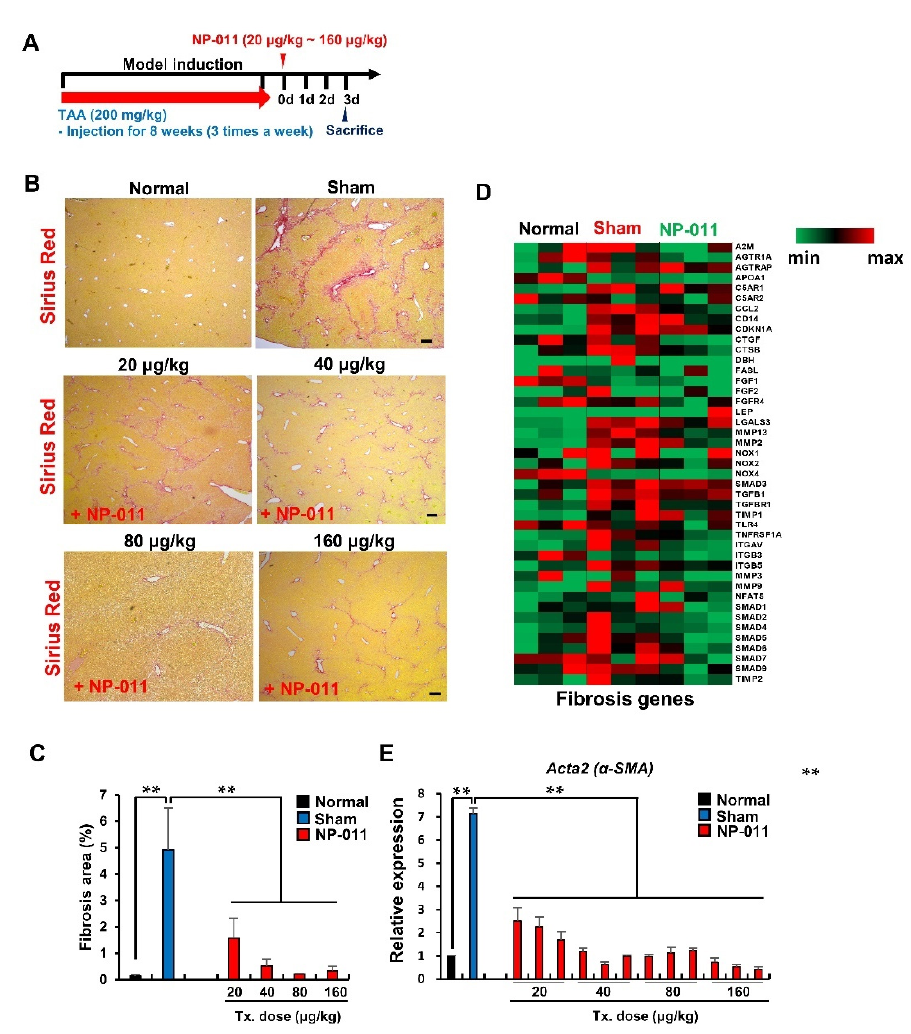
Figure 2. Resolution of fibrosis by administration of various doses of NP-011. ( A ) Overall schematic schedule for testing the efficacy of the NP-011 in a liver fibrosis model. The red arrow indicates the period for TAA administrations for inducing liver fibrosis. ( B ) Representative images for comparing the fibrotic areas (Sirius red stained areas) in the liver of normal mice, a TAA-induced liver fibrosis model, and an NP-011-administered liver fibrosis model at various doses (20–160 μ g/kg). Scale bar, 200 μ m. ( C ) Quantitative analysis of the fibrotic areas in the livers of tested mice in B. Tx. indicates treatment. Bars represent the means ± SD from four mice in each group. ** p < 0.01, Student’s t -test. ( D ) Heatmap data show fibrosis-relevant genes observed in livers from normal mice, TAA-induced mice, and NP-011-administered liver fibrosis mice. ( E ) Comparison of α -SMA ( Acta2 ) expression in the liver of normal mice, a TAA-induced liver fibrosis model, and an NP-011-administered liver fibrosis model by quantitative PCR. Tx. indicates treatment. ** p < 0.01, Student’s t -test.